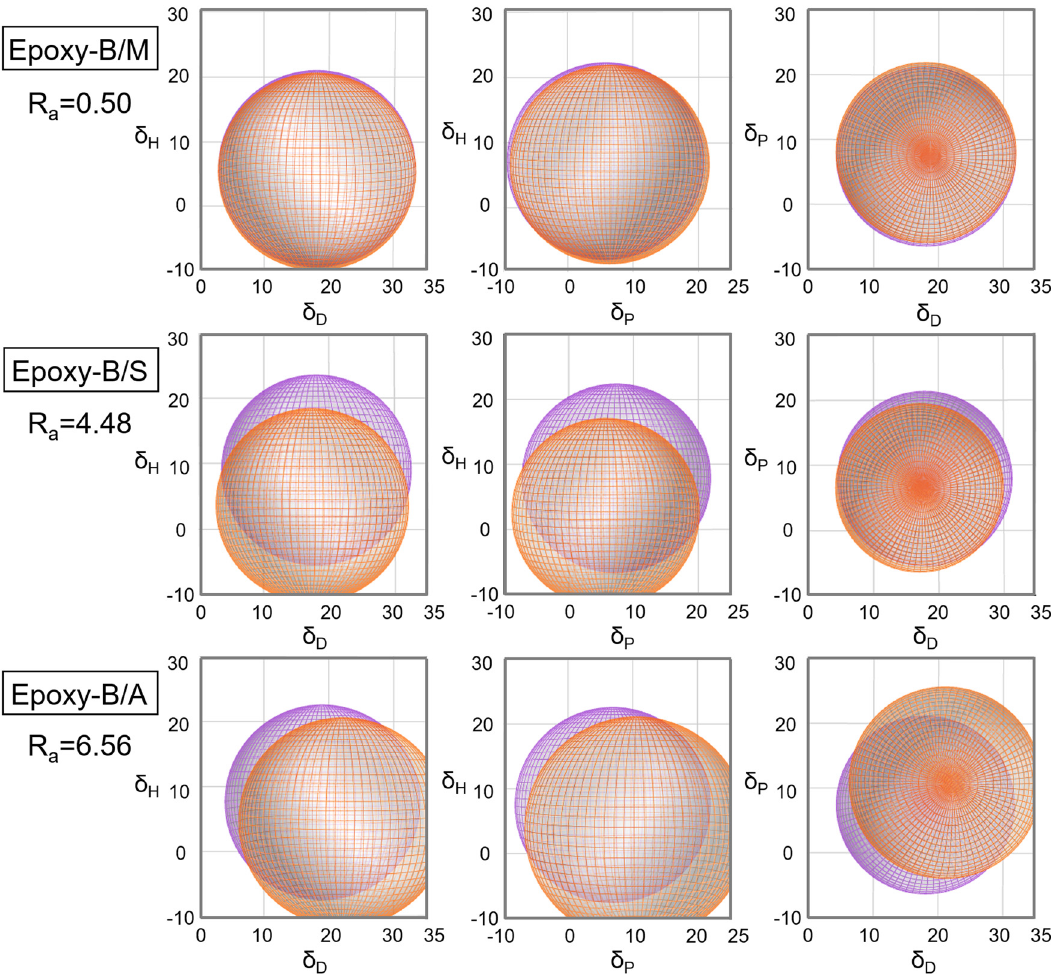
Figure 4: HSP graphs from three - plane projections ( front, top and left views ) . The purple color sphere represents the neat epoxy resin, and the orange color represents core/shell nanoparticles. The R a values are shown to the left of the HSP graphs.